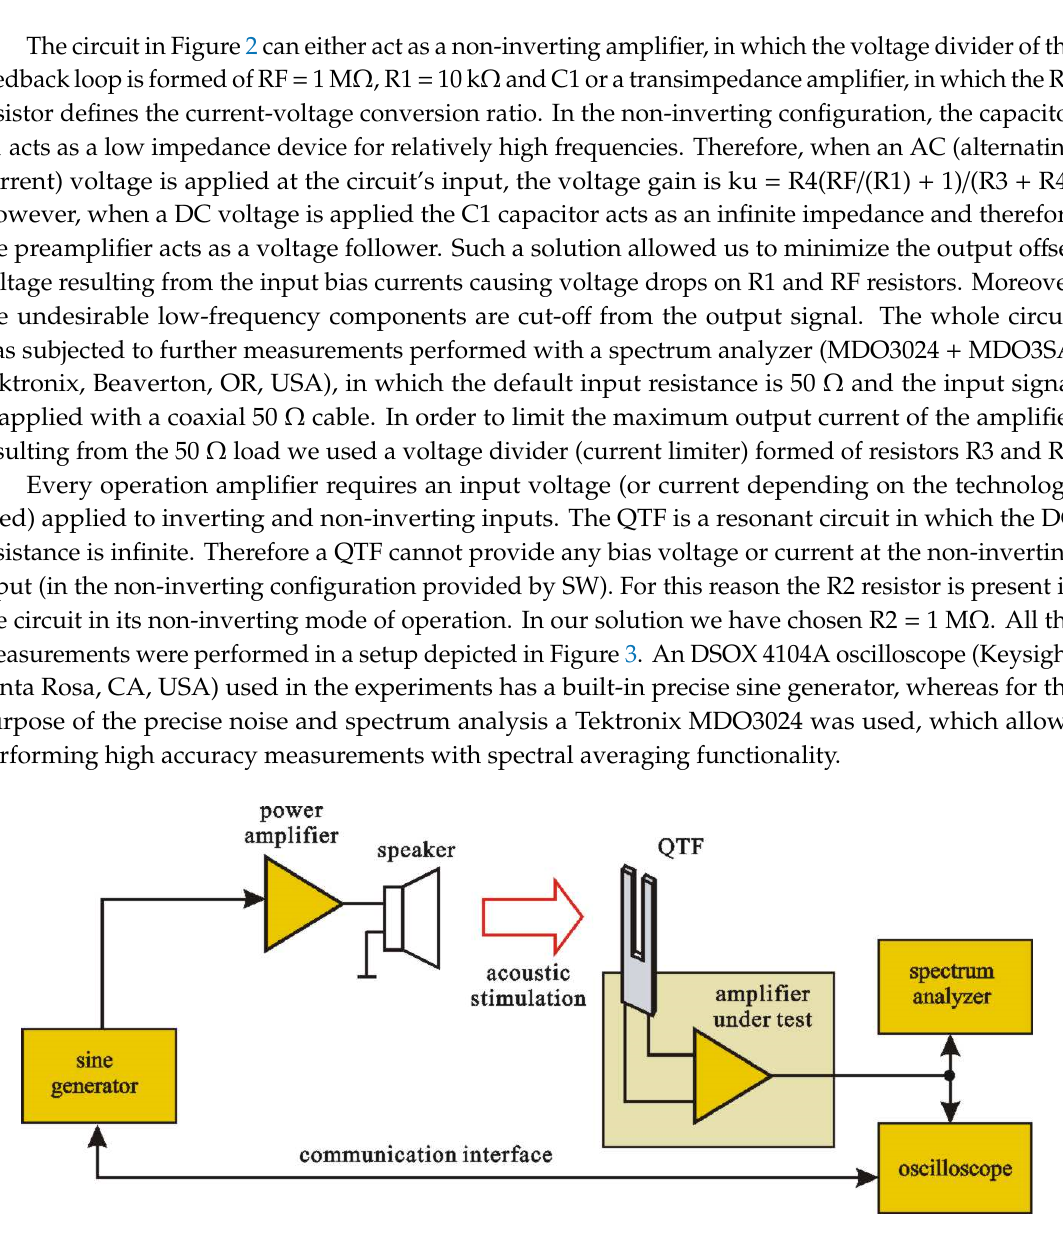
Figure 3. Setup used in the measurements.